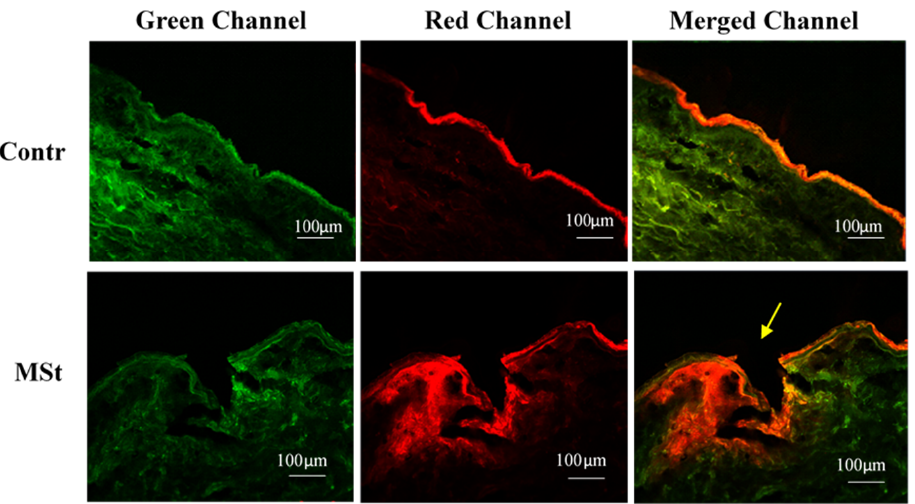
Figure 3. LSCM images of human skin treated with E-DiI following application of microstructures, compare to control (treatment without microstructures). Green intensity is due to auto-fluorescence of the skin sample. Red intensity indicates di ff usion of E-DiI around the microchannel area created by MSt insertion. Microstructures enhanced the di ff usion of E-DiI into deeper skin